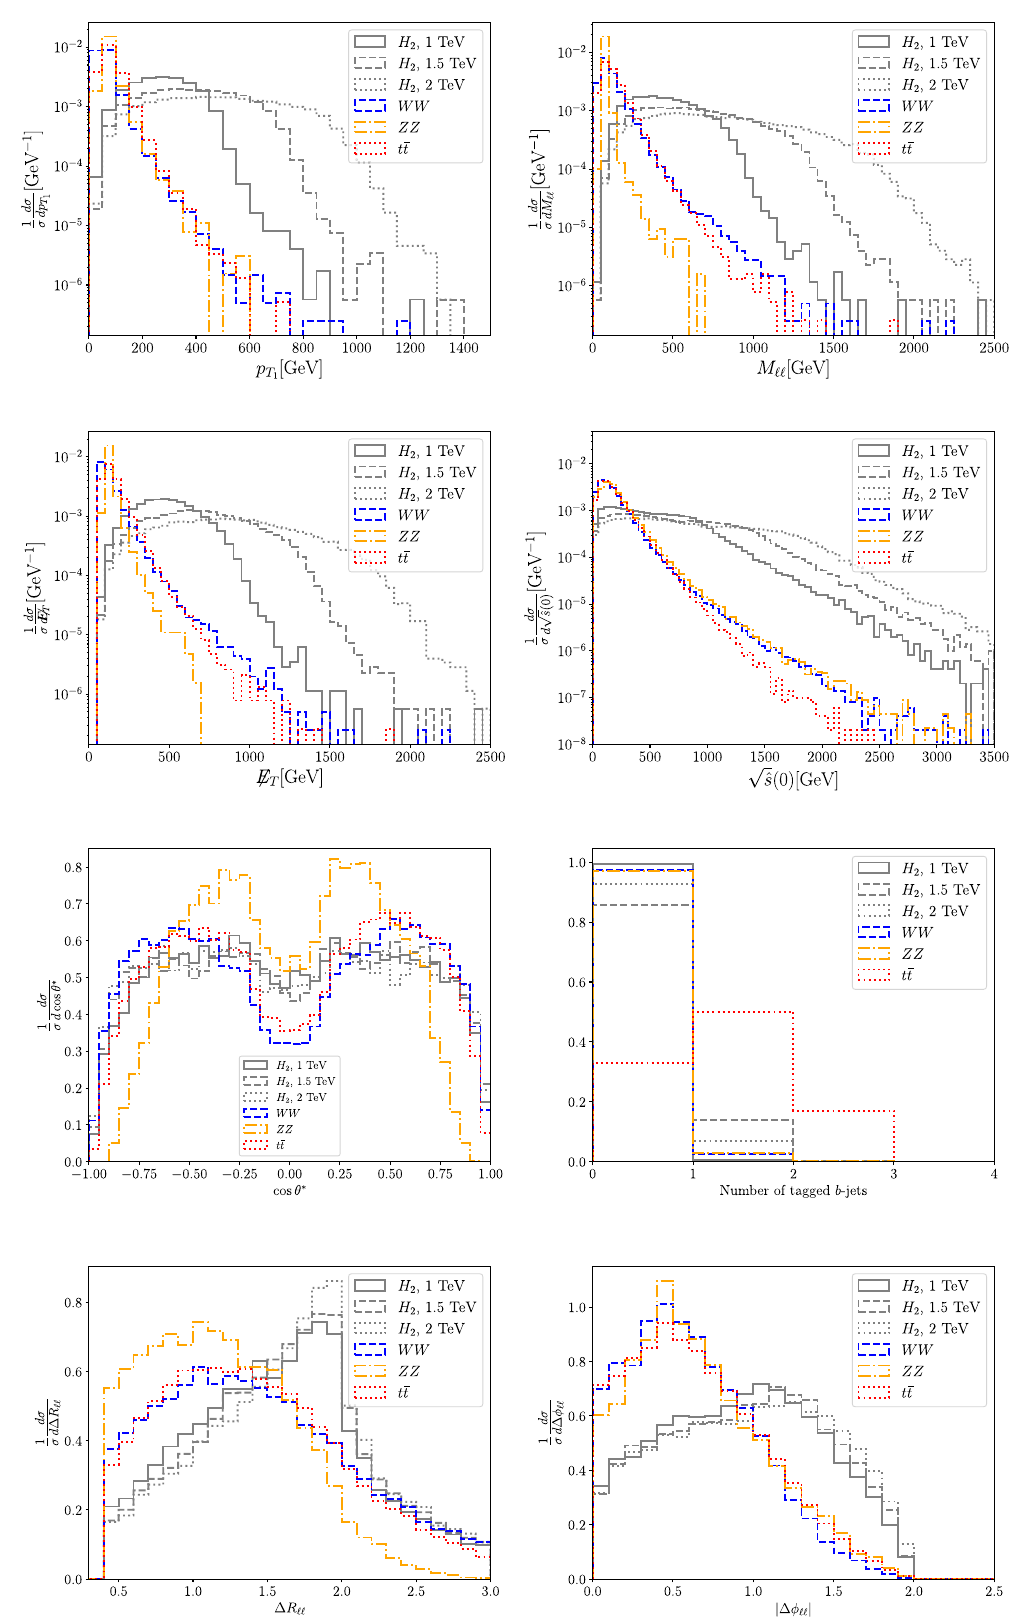
Fig. 1 Some of the kinematic distributions of Higgs bosons and its corresponding SM backgrounds chosen to represent the events for regression and